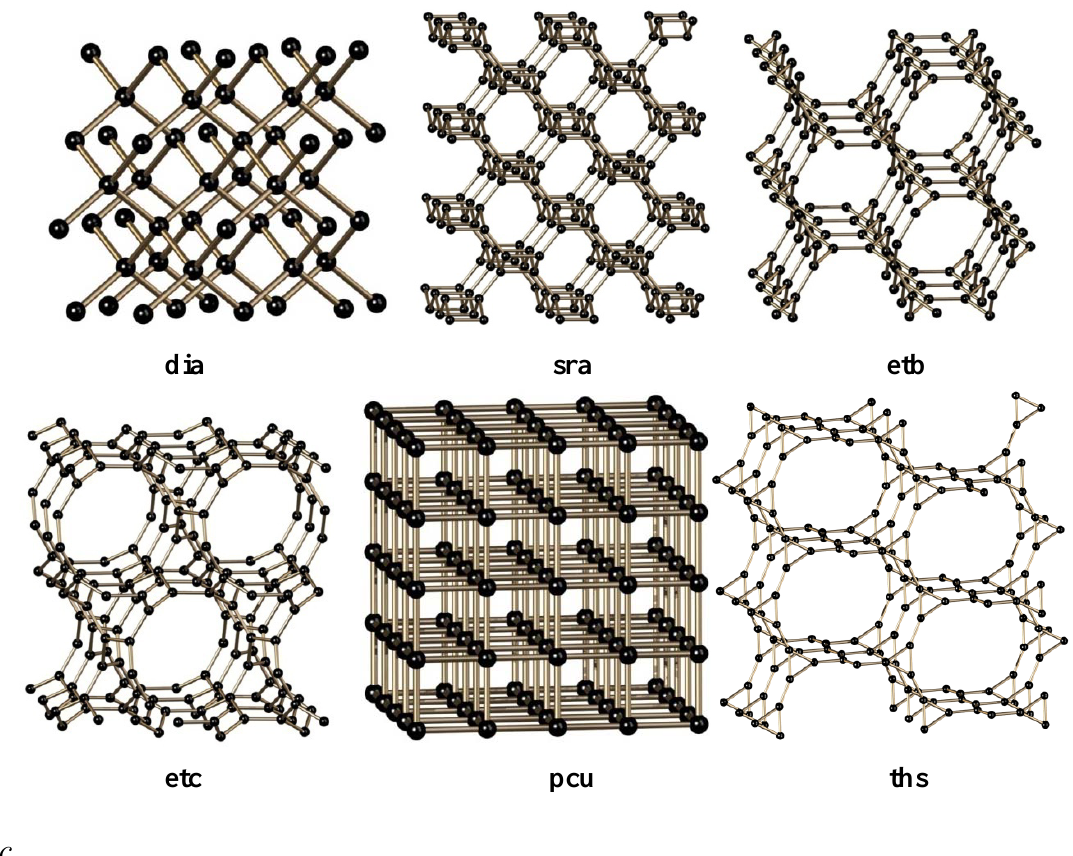
Figure 4. Topology of the uninodal three-dimensional